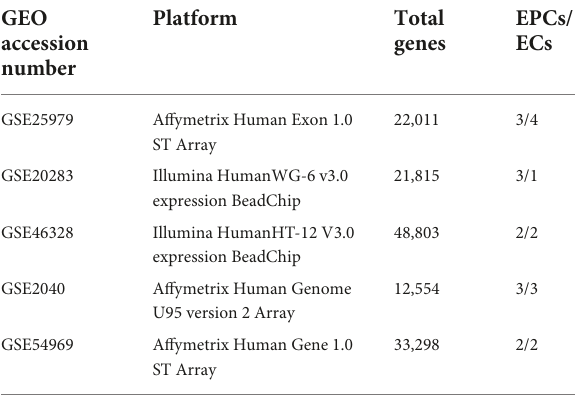
TABLE 1 Gene expression omnibus (GEO) datasets used for this